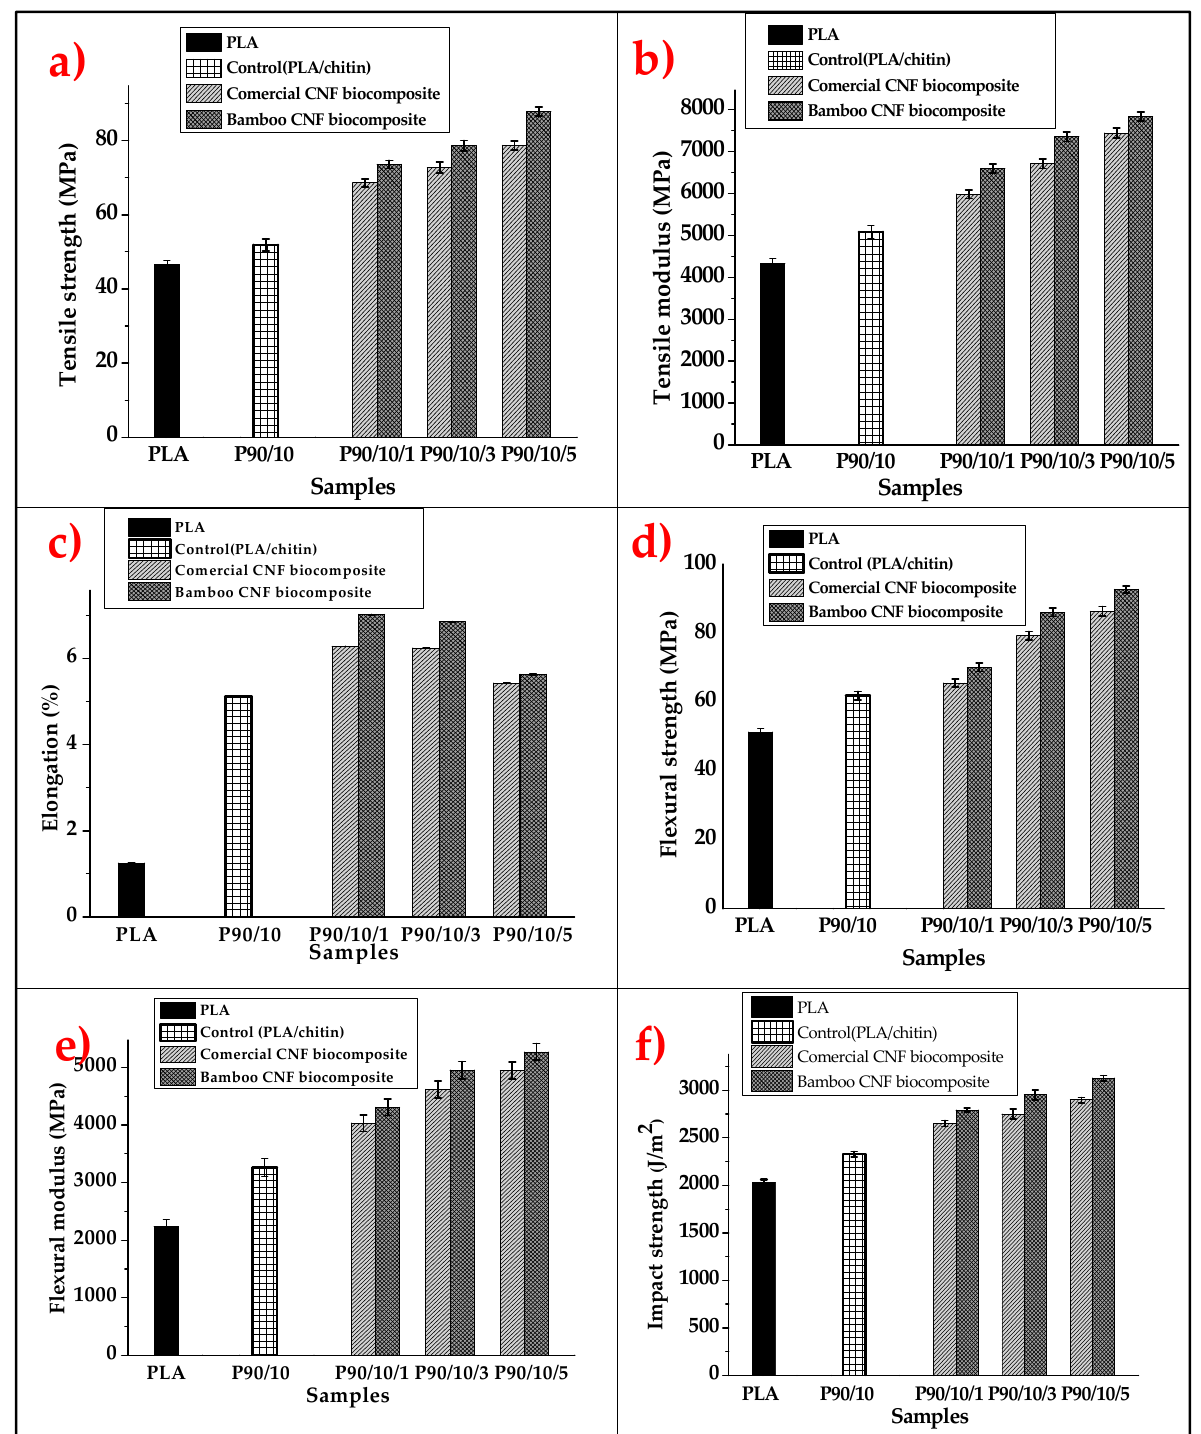
Figure 4. Comparative analysis of ( a ) tensile strength; ( b ) tensile modulus; ( c ) elongation; ( d ) flexural strength; ( e ) flexural modulus; and ( f ) impact strength properties of bamboo and commercial CNF ‐ reinforced bionanocomposites.